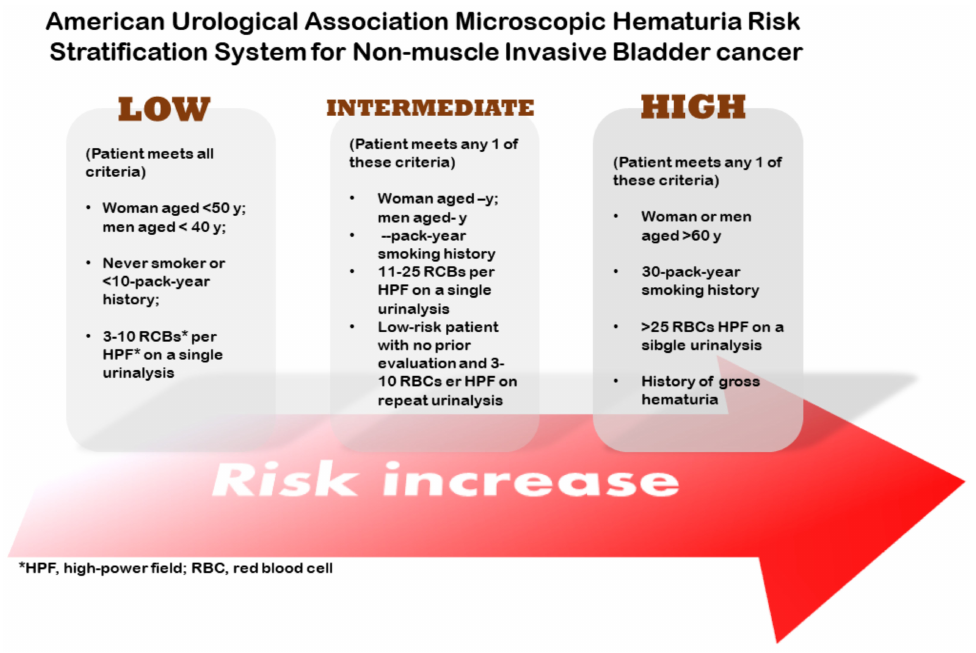
Figure 4. Stratification system for superficial bladder